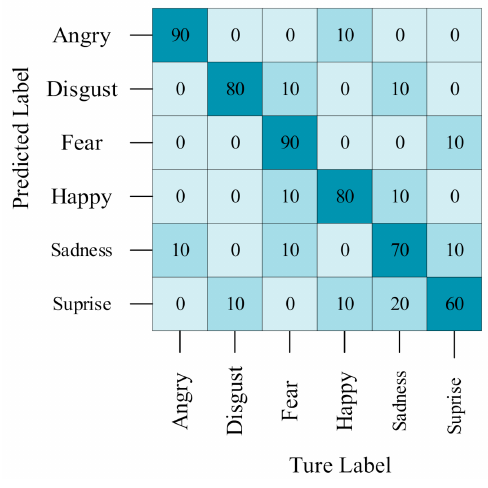
Figure 9. Test confusion matrix of